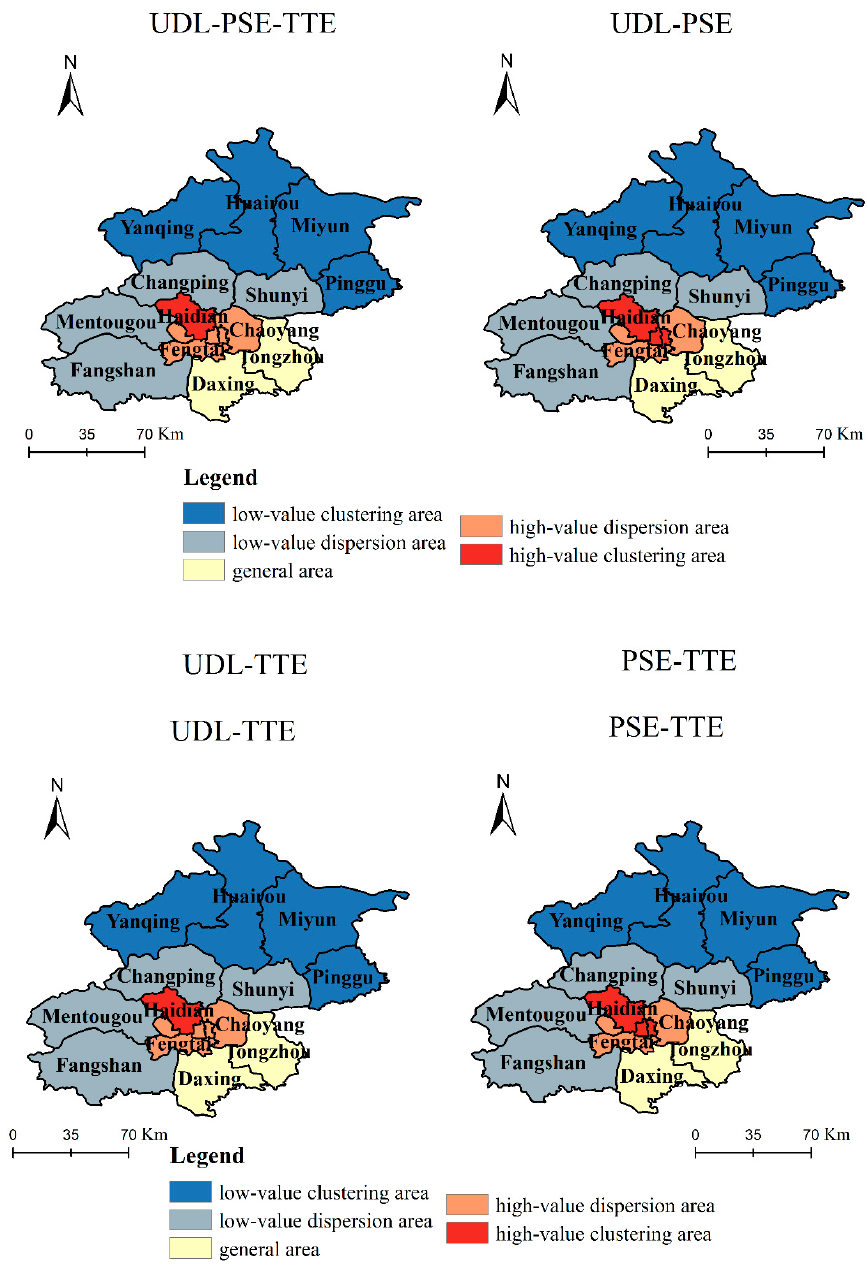
Figure 6. Spatial distribution of high-low-value clustering points with different degrees of coupling coordination.